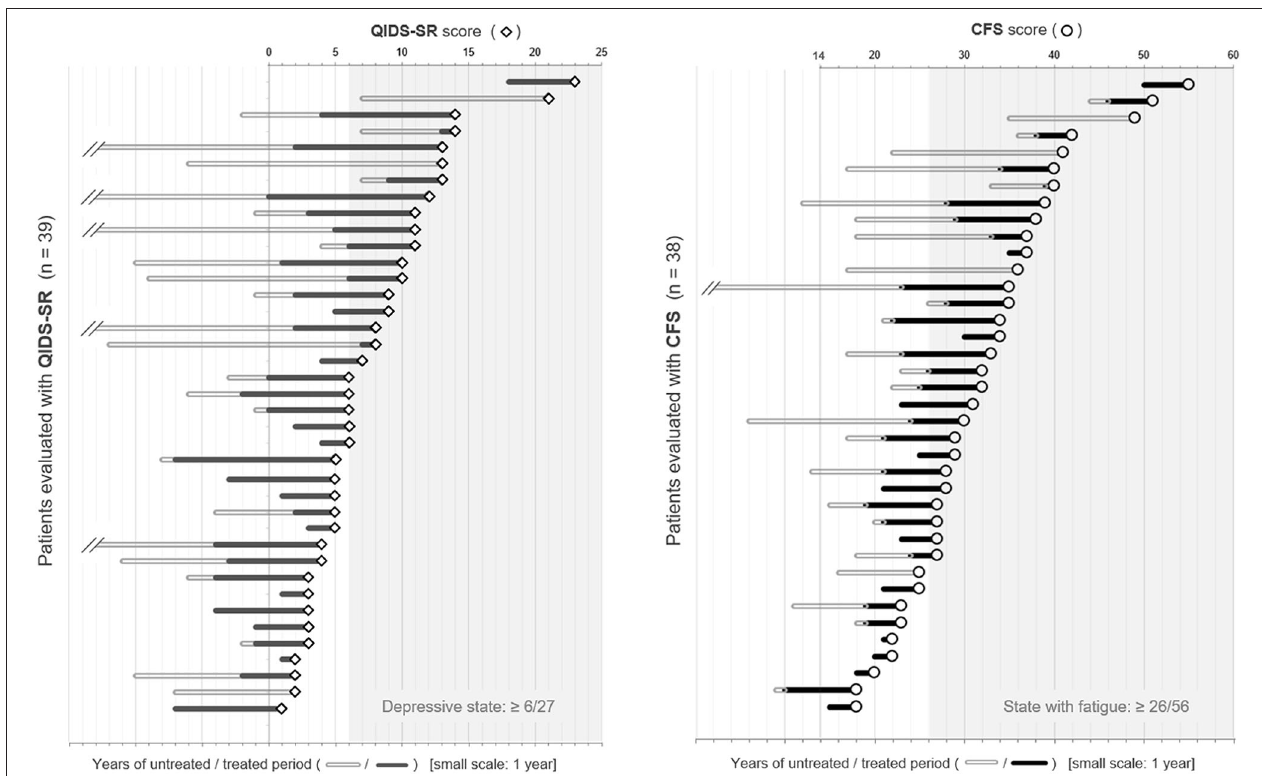
FIGURE 2 | Dot plots of QIDS-SR and CFS scores with the duration of the untreated/treated periods. The patients listed were placed in order of the scores of each self-reported battery. The length of the bars on the left side of each plot represents the duration of the untreated/treated period with relapse prevention therapies in years. CFS, Chalder Fatigue Scale; QIDS-SR, self-reported Quick Inventory of Depressive